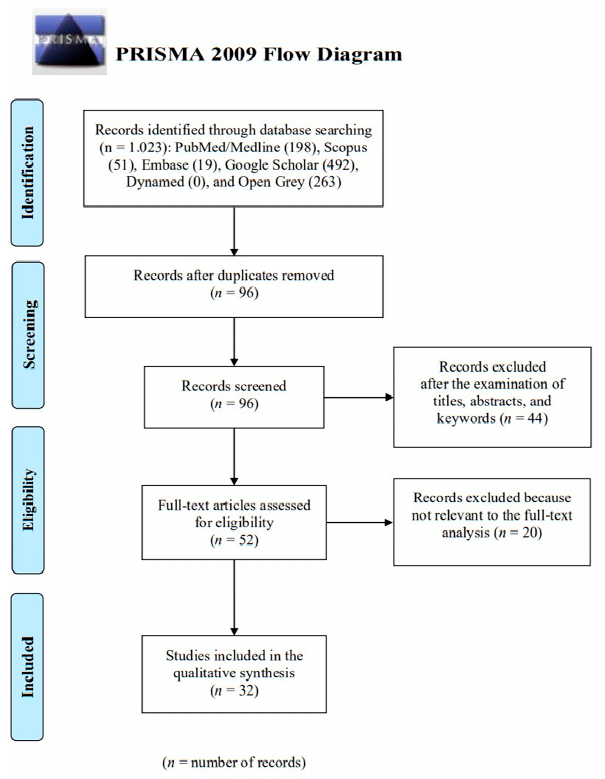
Figure 5. Prisma flow diagram for the records screening process.